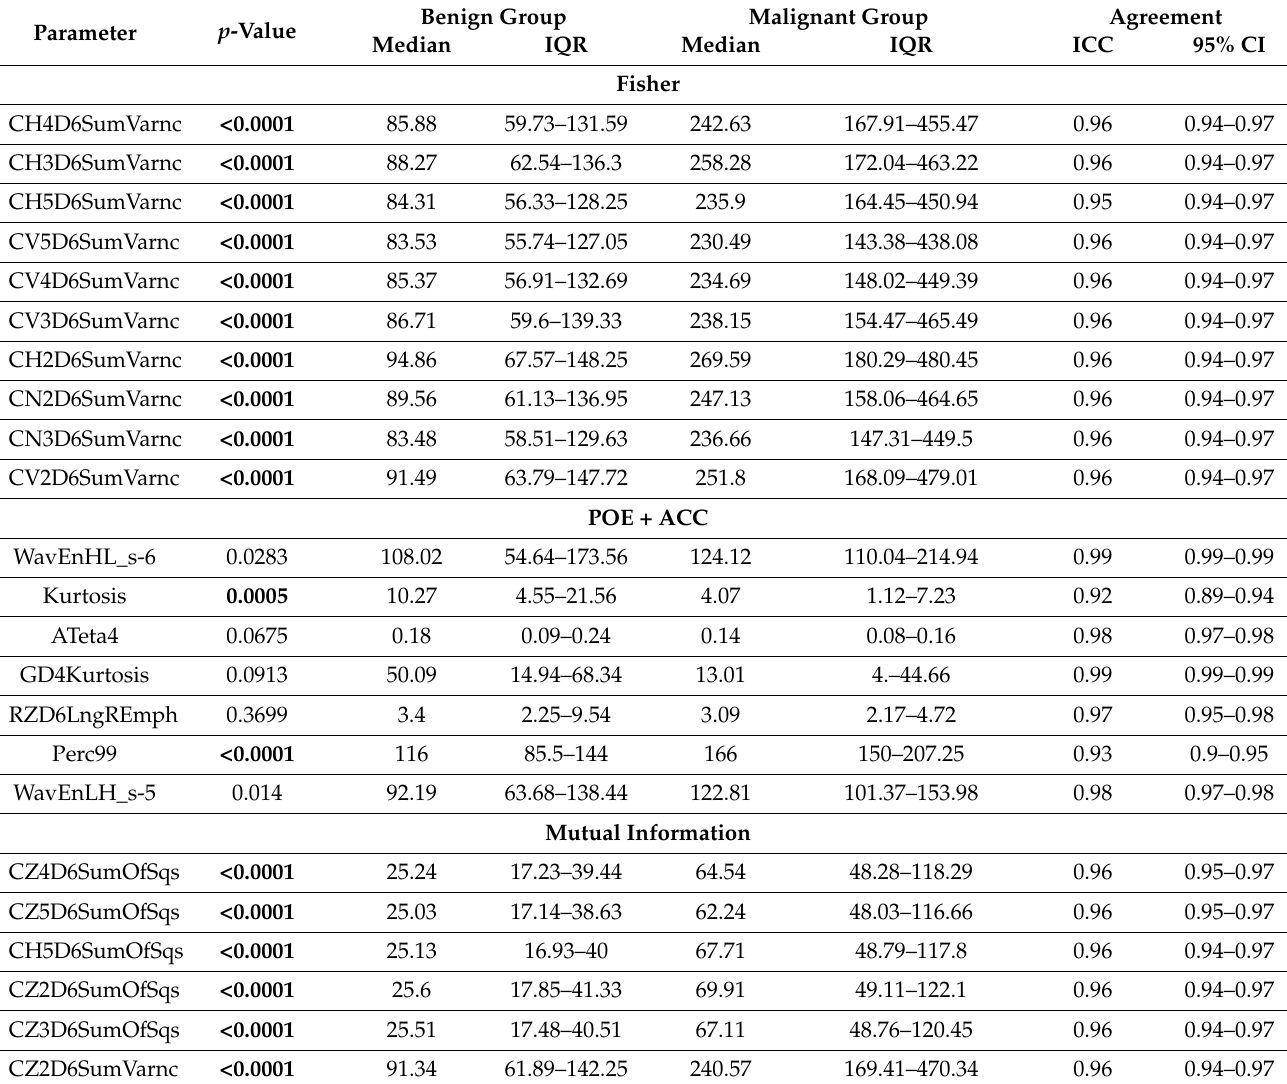
Table 1. The univariate analysis (Mann–Whitney U test) and the intra-reader agreement evaluation results.